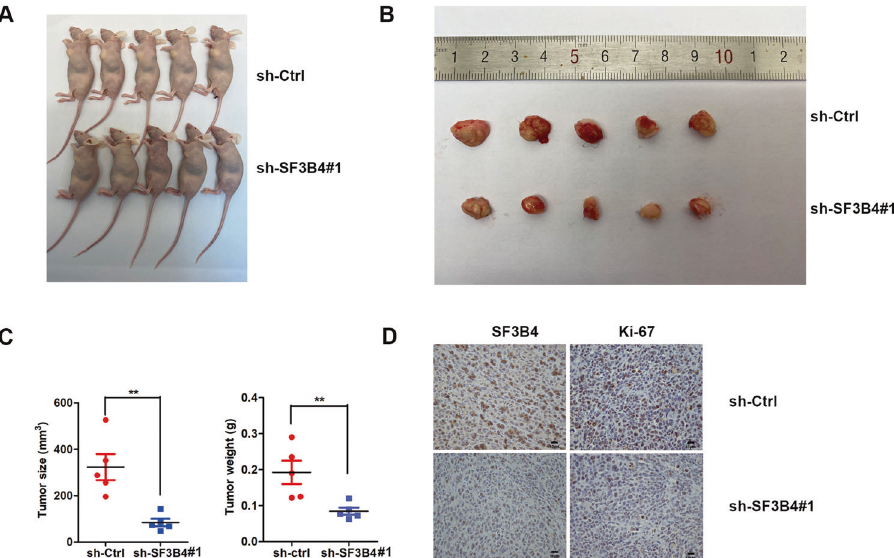
Fig. 3 SF3B4 depletion suppresses xenograft tumorigenesis in vivo. A Images of xenograft tumors in mice ( n = 5 per group). B Images of tumors isolated from nude mice implanted with sh-SF3B4#1 ( n = 5) and sh-Ctrl ( n = 5) CaSki cells. C Tumor weight and size in each group. D Images of immunohistochemical staining for SF3B4 and Ki-67 in xenograft tumor tissues. P value was obtained by Unpaired t-test. * P < 0.05, ** P <